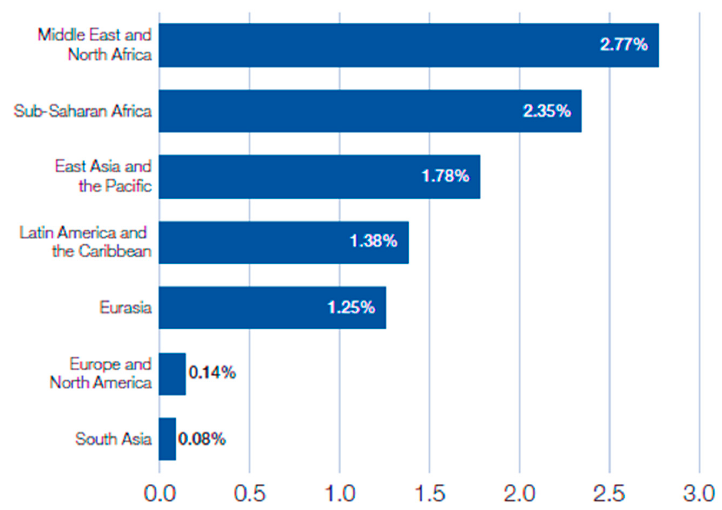
Figure 1. Change in median competitiveness performance, by region (percentage change 2018–2019). Source: The Global Competitiveness Report (2019). Page